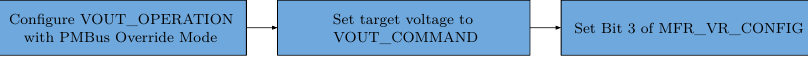
Figure 6: Command sequence to change the voltage via